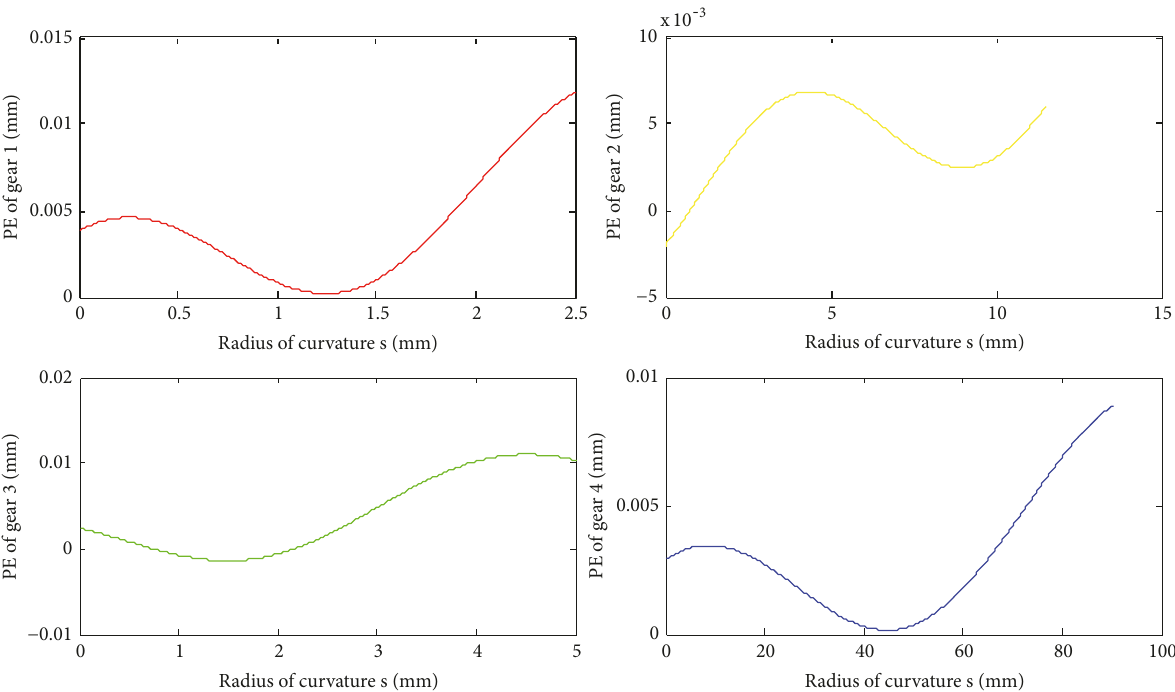
Figure 4: PE curves of four